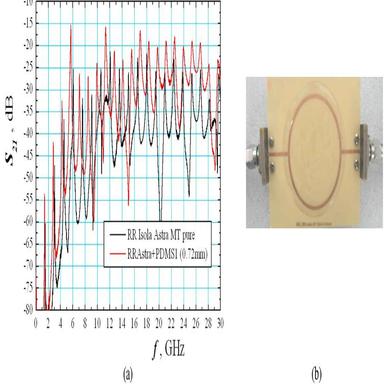
(a) Resonance curves of microstrip RR of averaged diameter 40 mm on substrate ISOLA Astra MT 3.0 without and with covering PDMS sample and (b) image of the covered RR by PDMS sample of diameter 46 mm.